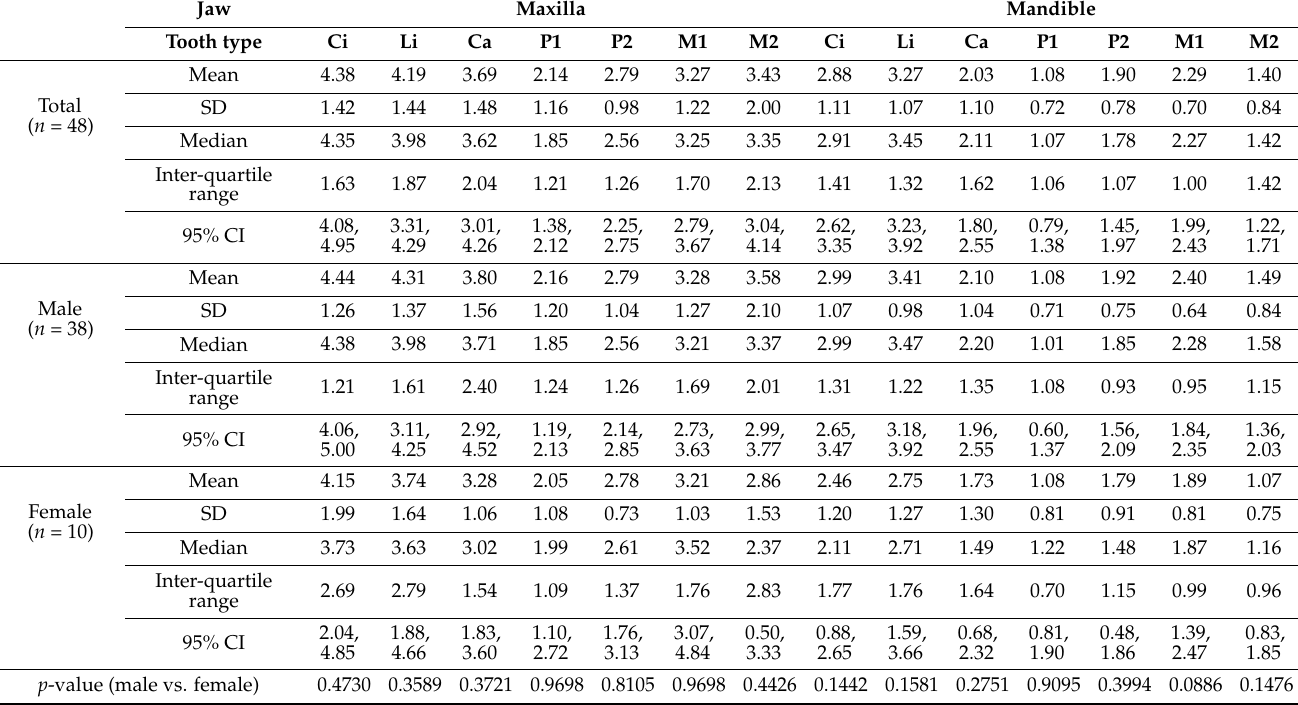
Table 2. Height of the attached gingiva (in mm).